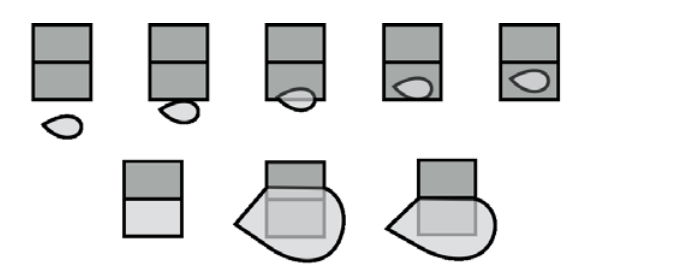
Figure 12: The set of tile relations for neighboring tiles that can produce disjoint (top), and the corresponding tile relations that cannot (bottom).